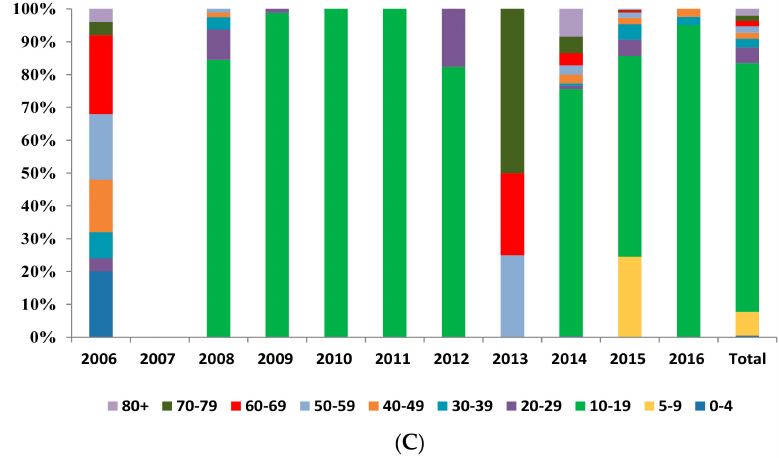
Figure 2. The distribution of 132 acute gastroenteritis outbreaks associated with noroviruses in China during 2006 to 3 April 2016. The bar in the figures were all generated by the number of outbreaks ( n = 132). ( A ) Setting distribution. ( B ) Month distribution. ( C ) Age distribution.